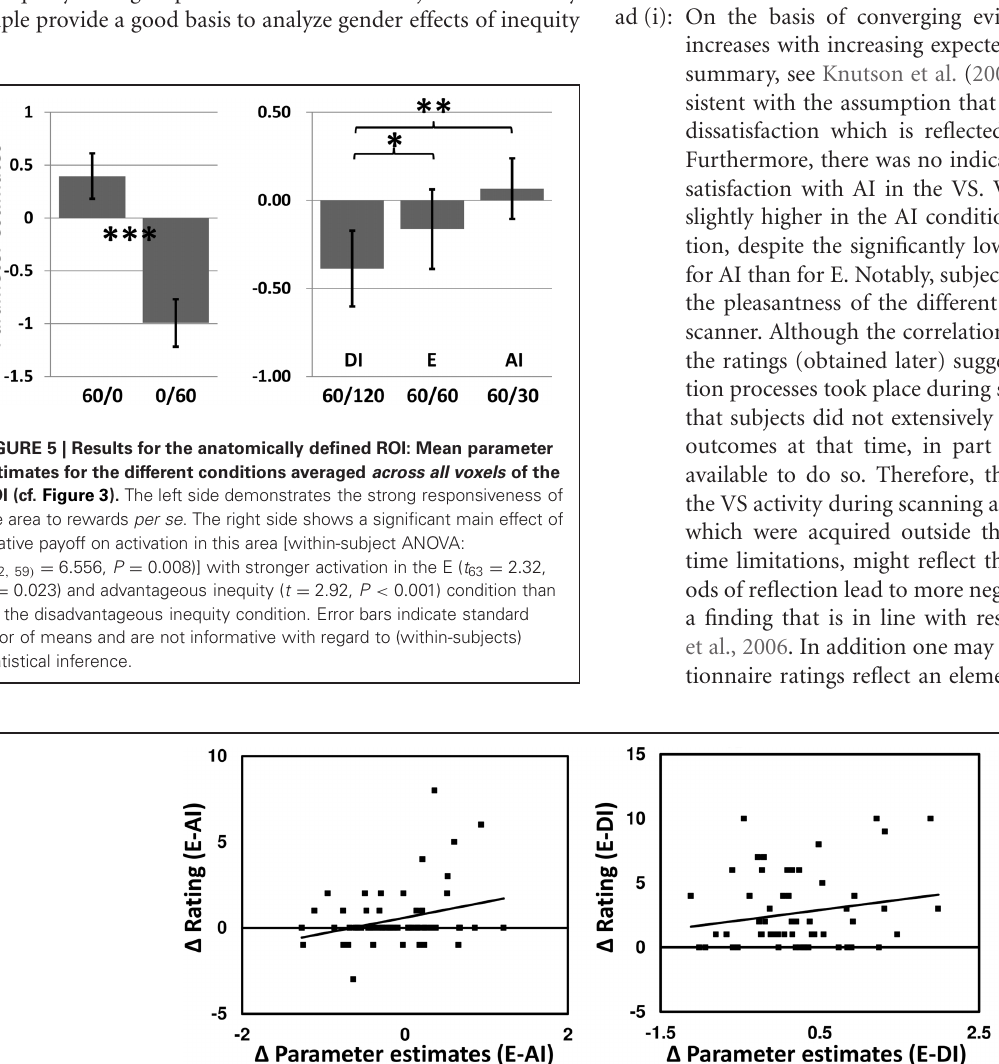
association between pleasantness and signal for AI evaluation ( r = 0.29, P = 0 . 01, one-sided) and a non-significant trend for DI evaluation ( R = 0 . 18, P = 0 . 08,